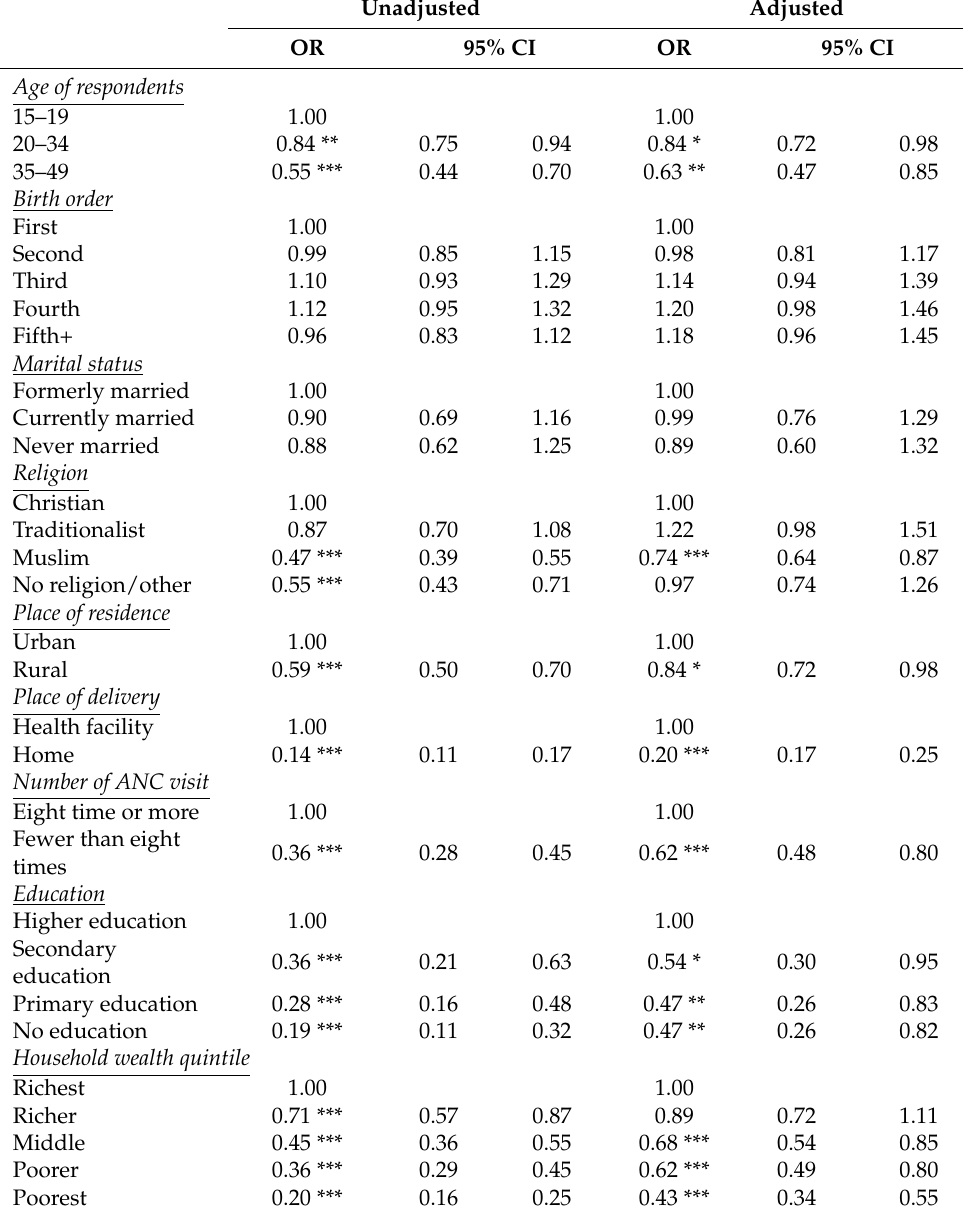
Table 2. Unadjusted and adjusted logit models predicting ‘maternal TT vaccination’ in Benin. Unadjusted Adjusted OR 95% CI